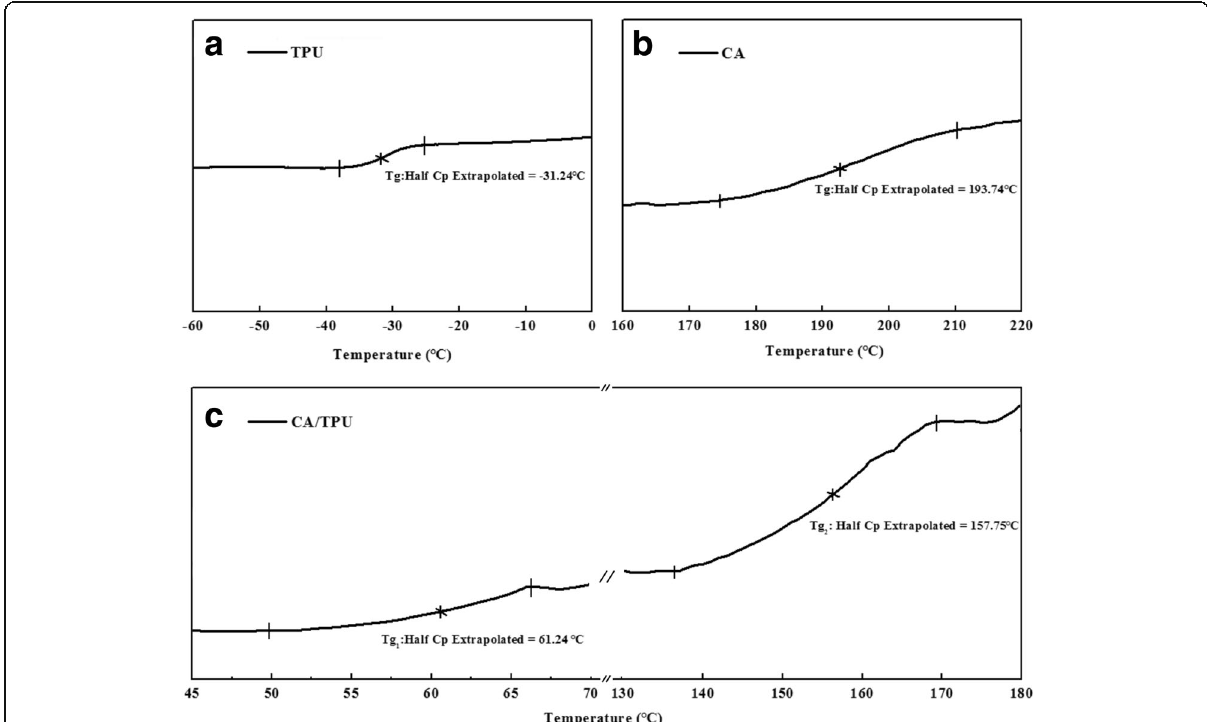
Fig. 8 DSC thermograms of the CA/TPU component system including pure polymers and the blends: a TPU coagulum, b CA coagulum, and c CA/TPU blend